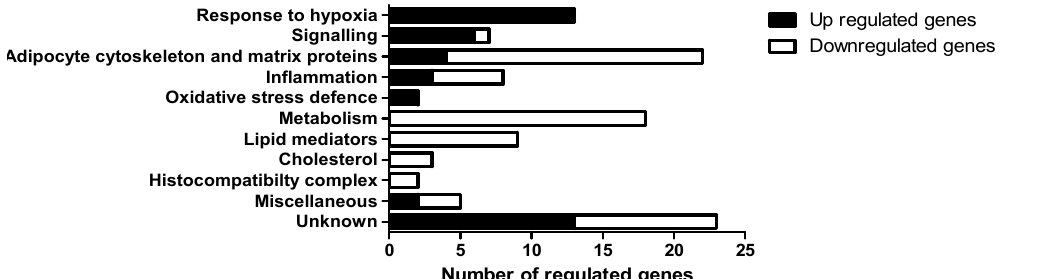
Figure 4. Categorization of the 112 unique genes differentially regulated ( p < 0.01, absolute fold change >1.25) by oxygen restriction (OxR). Filled black bars represent up regulated genes and open bars represent down regulated genes.